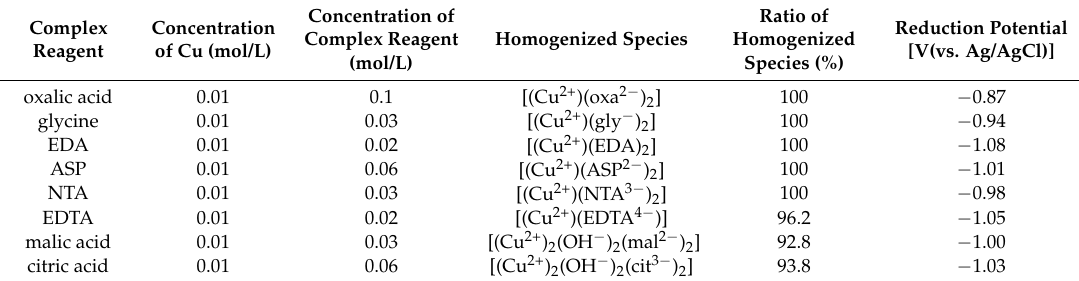
Table 1. Relationship between homogenized species and solution condition calculated, and reduction potential in the case of oxalic acid, glycine, ethylenediamine (EDA), nitrilotriacetic acid (NTA), etylenediaminetetraacetic acid (EDTA), malic acid, and citric acid.